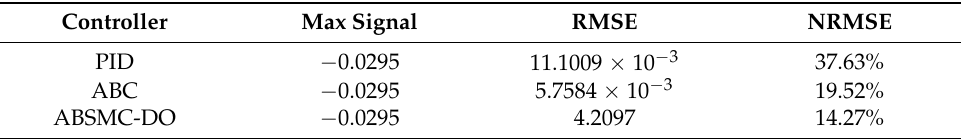
Table 3. Normalized performance index of position control under different controllers. NRMSE, normalized